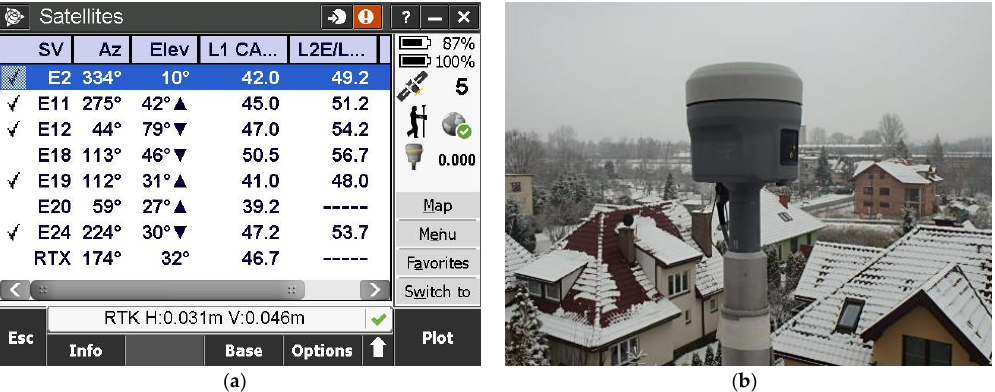
Figure 2. ( a ) Static measuring point, Trimble R10 antenna, ( b ) Measurement screen of the TSC3 controller.